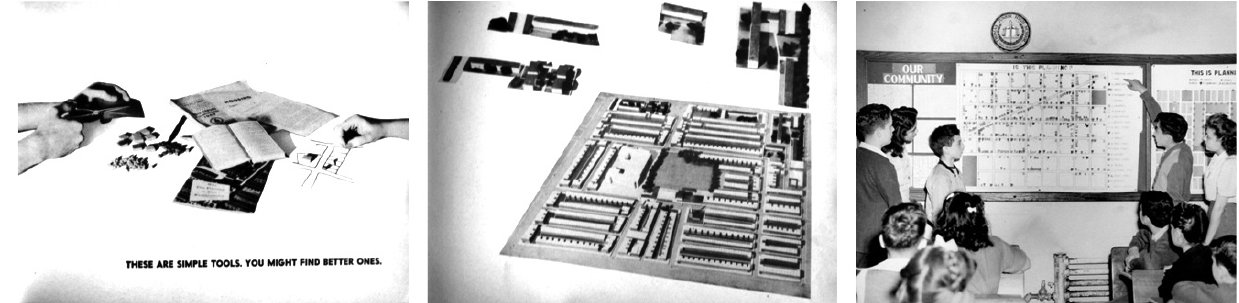
Figure 6. Tools for neighborhood planning from You and Your Neighborhood . Source: Stonorov and Kahn